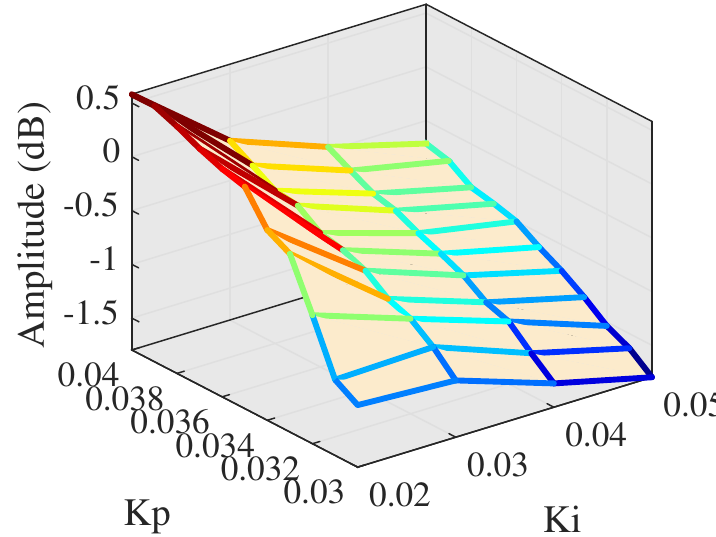
Figure 21. Amplitude at low